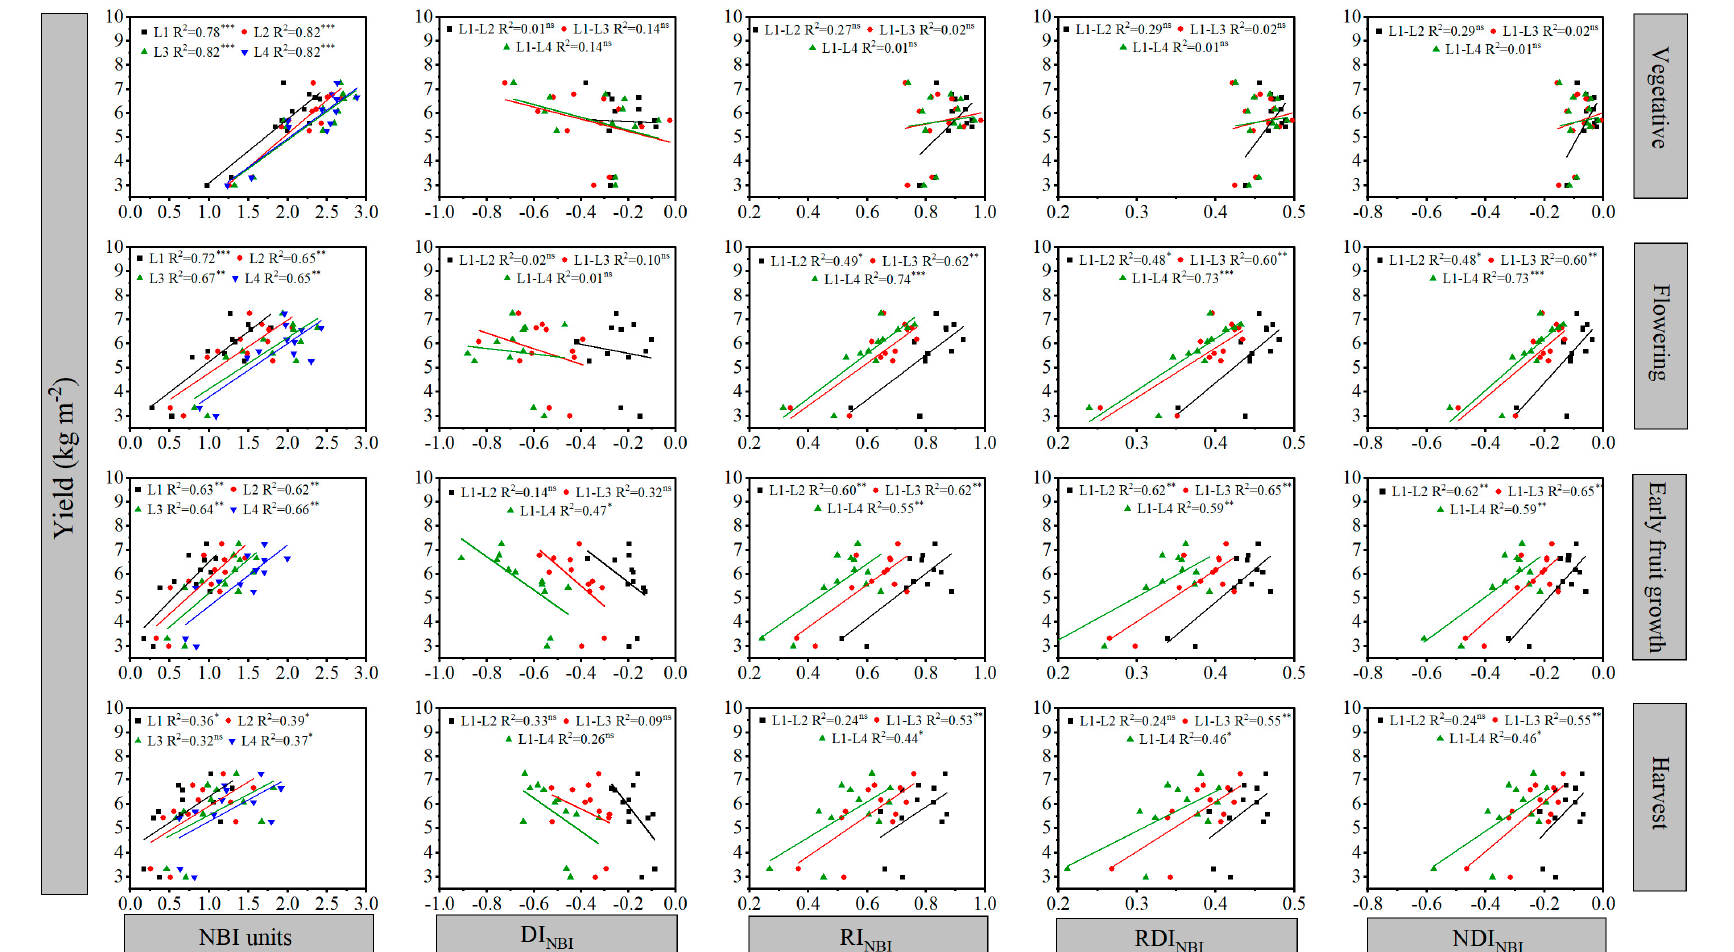
Figure 4. The relationships between absolute NBI measurements and several normalized NBI indices (DI, RI, RDS, NDI) with total fruit yield (kg m − 2 ) at different phenological stages of sweet pepper, for calibration data. L1, L2, L3 and L4, refer to the latest (most recent), second, third and fourth fully expanded leaf, respectively. Asterisks show significance of regressions: ***, p < 0.001; **, p < 0.01; *, p < 0.05; ns, p > 0.05.